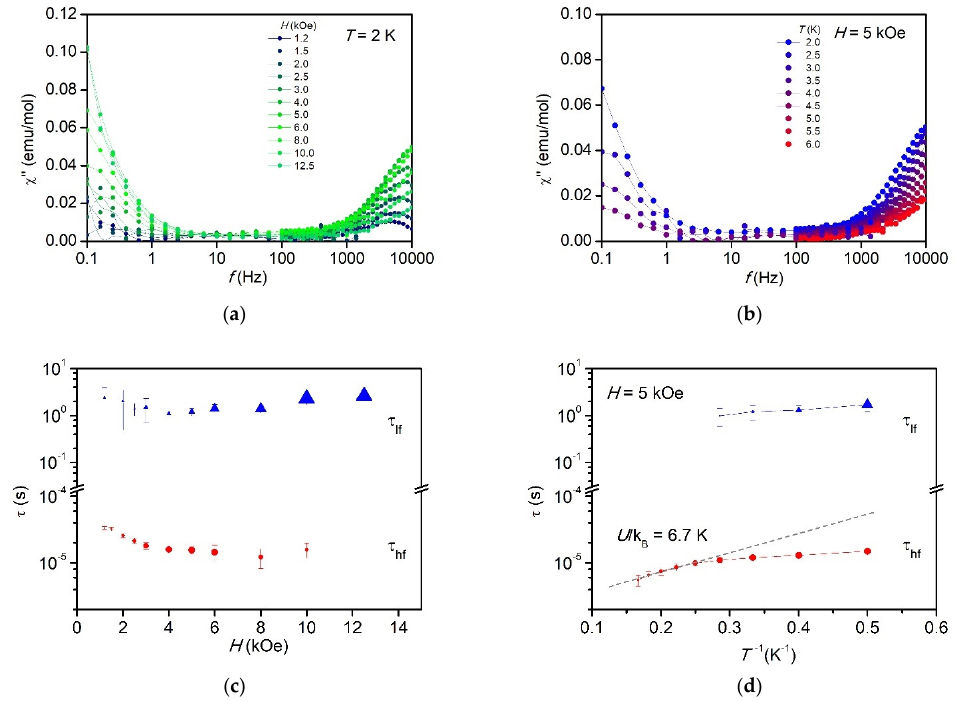
Figure 7. Magnetic relaxation for compound 1 . Top: Out-of-phase component of the susceptibility as function of frequency, ( a ) at constant T = 2 K and diverse applied fields, and ( b ) at constant field H = 5 kOe and different temperatures. Bottom: spin relaxation time as a function of the field, τ ( H ) at T = 2 K ( c ), and as a function of the inverse temperature, τ (1/ T ) at H = 5 kOe ( d ), for the two different observed processes, τ lf and τ hf .